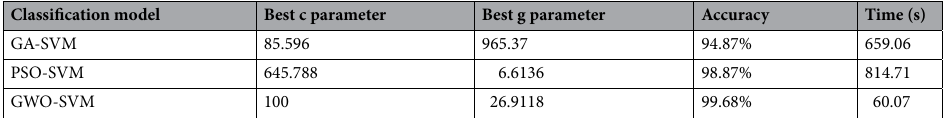
Table 5. Comparison table of results obtained by three optimization algorithms for four-opamp biquad highpass filter.